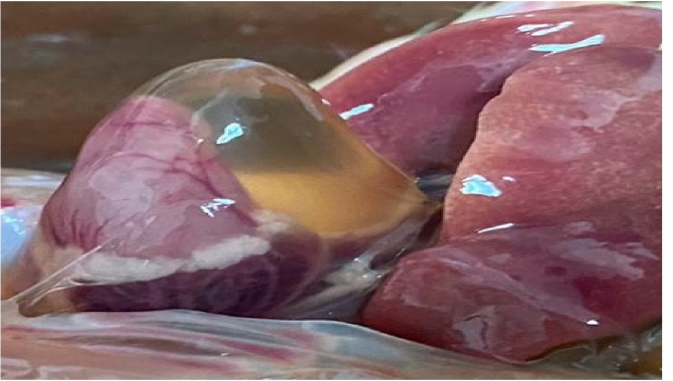
Figure 2. Broiler with ascites in